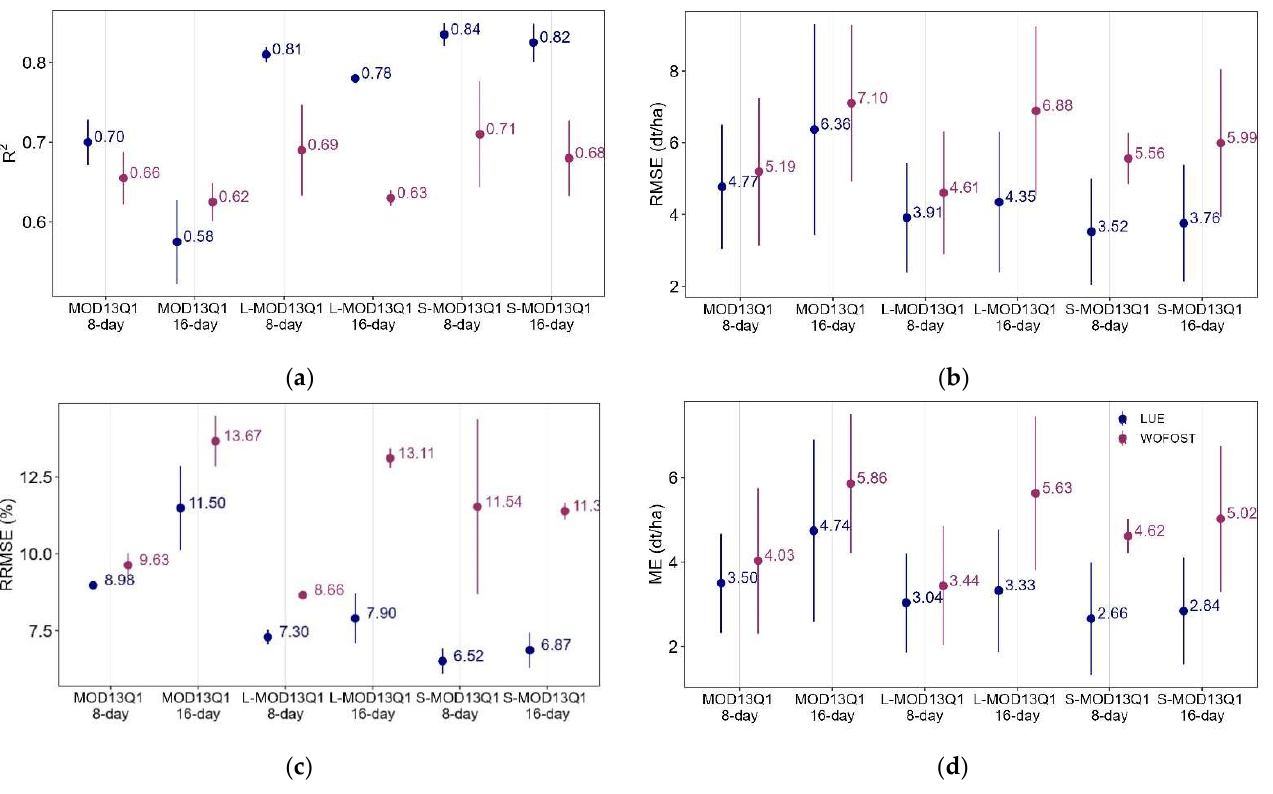
( d ) Figure 14. The box plots show the comparison of accuracies ( a , c ) R 2 values and ( b , d ) RMSE values obtained from the referenced yields (at 95% confidence interval), with LUE ( a , b ) and WOFOST ( c , d ) modelled yields including climate stress factors (dark blue and pink) and the modelled yields ex- cluding the climate stress factors (sensitivity analysis) (light blue and pink). 3.5. Suitable Crop Growth Model The statistical analysis showed the R 2 , RMSE, RRMSE, and ME values of the model’s (LUE and WOFOST) performance, including climate stress factors’ effect on both WW and OSR in Bavaria in 2019 (Figure 15). The LUE model resulted in a higher R 2 (>0.78) for the 8- and 16-day products of L-MOD13Q1 and S-MOD13Q1 than the WOFOST model (R 2 < 0.71). Similarly, the RMSE and ME of these products show more accurate results with the